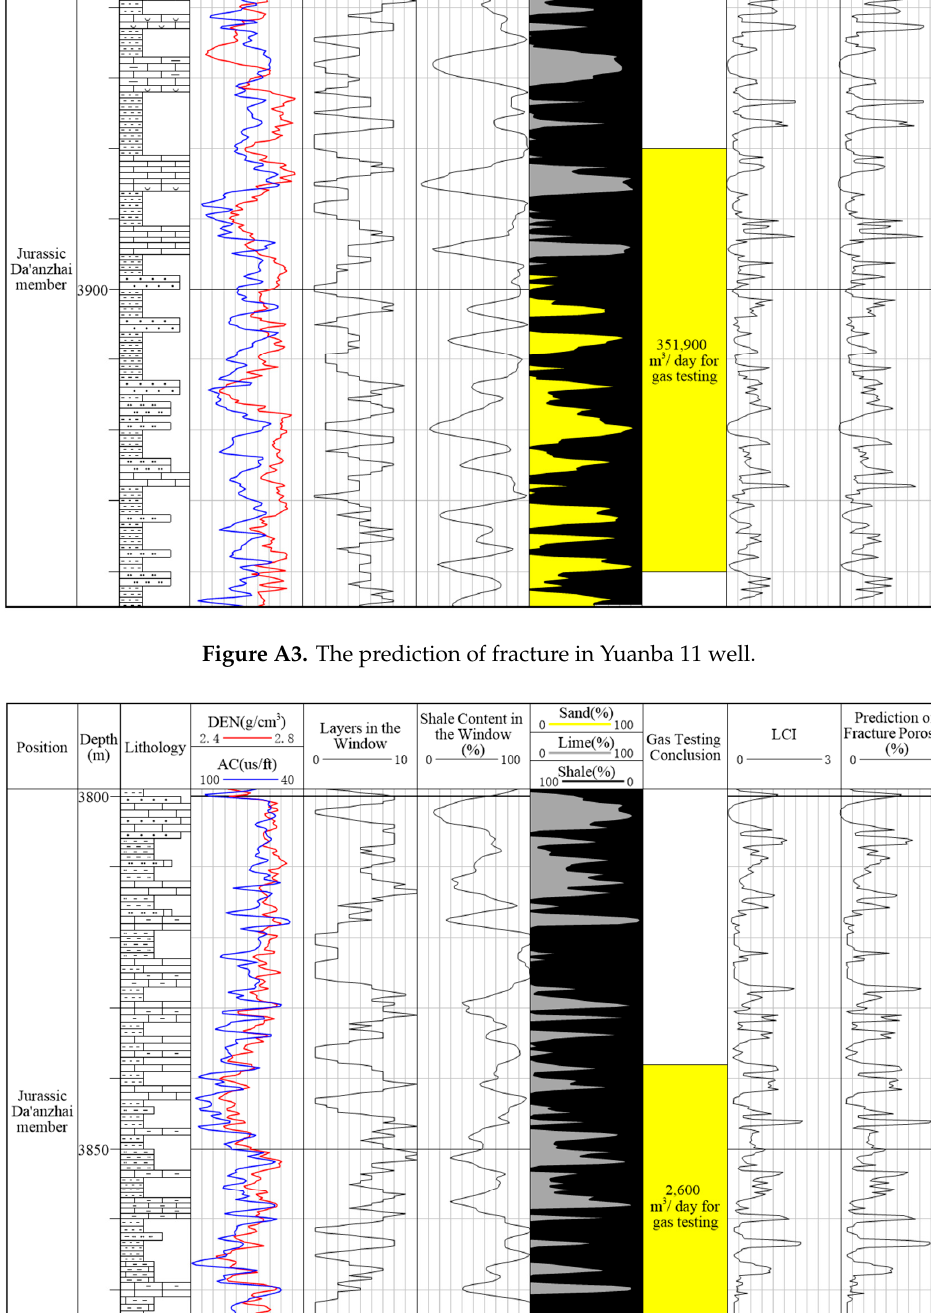
Figure A4. The prediction of fracture in Yuanba 9 well.